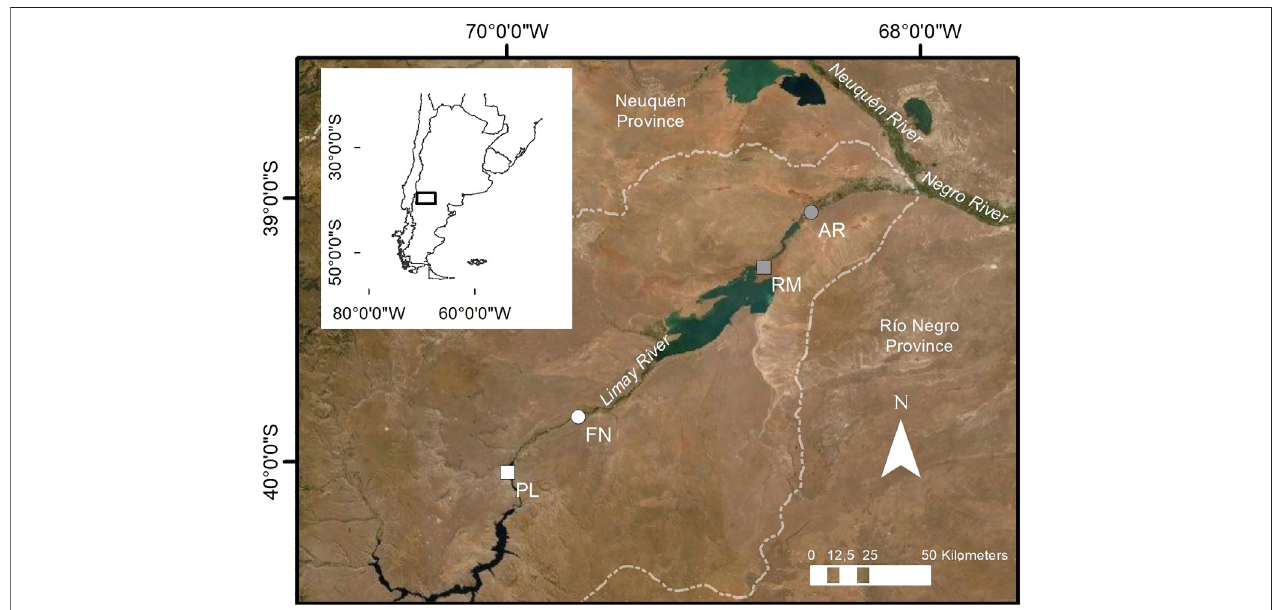
FIGURE 1 | Geographic location of sampling river (circles AR, Arroyito; FN, Fortín Nogueira) and reservoir (squares RM, Ezequiel Ramos Mexía; PL, Pichi Picún Leufú) sites of Limay River, Patagonia, Argentina. White panels represent the not invaded sites and gray panels the invaded sites.